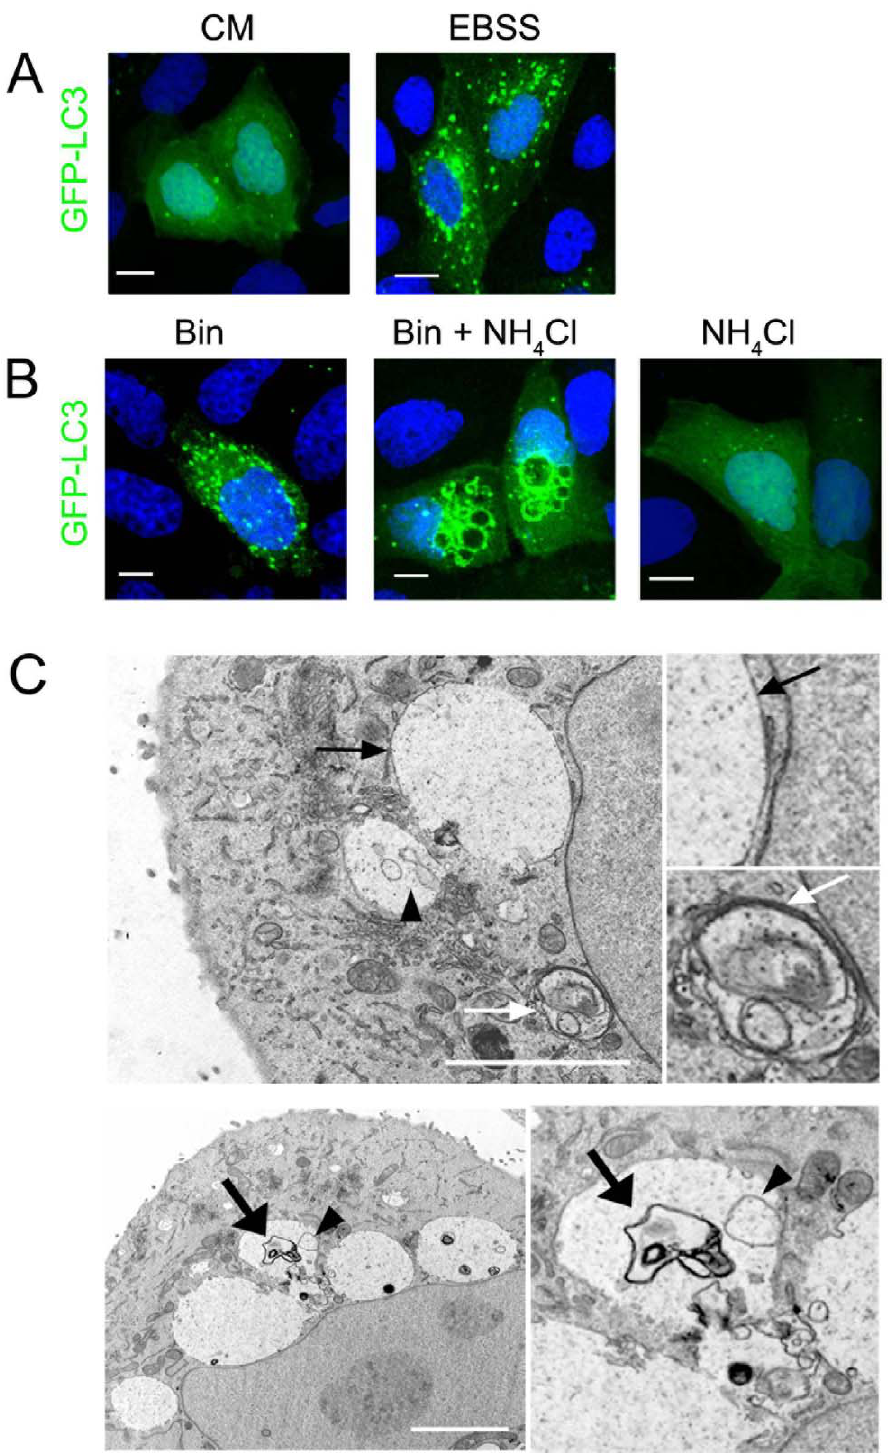
Figure 2. Bin-induced vacuoles originate from autolysosomes. (A) MDCK-Cpm1 cells transfected with GFP-LC3 and grown in complete medium (CM) or in nutrient-free medium (EBSS). Diffuse GFP-LC3 pattern seen in CM-grown cells is representative of non-autophagic cells. In contrast, GFP-LC3 punctated pattern seen in EBSS-grown cells is characteristic of autophagic cells. (B) Localization of the autophagic marker GFP-LC3 in cells treated with Bin for 6 h. To allow the detection of GFP-LC3 associated with autolysosomes NH 4 Cl (5 mM, final concentration) was added to the culture medium during the last hour of intoxication. A similar treatment with NH 4 Cl in the absence of toxin had no toxic effect on the cells and did not induce any change in GFP-LC3 pattern. (C) Bin-treated cells were processed for EM analysis as described in Experimental procedures. Vacuoles induced by Bin are electron-clear matrices enclosed by a single membrane (black arrows). In contrast, autophagosomes are double membrane vesicles (white arrows). Bin-induced vacuoles often contained vesicle-like structure (arrow-head) and partially degraded material (large black arrows). Bars, 5 m m (A and B); 2 m m (C).